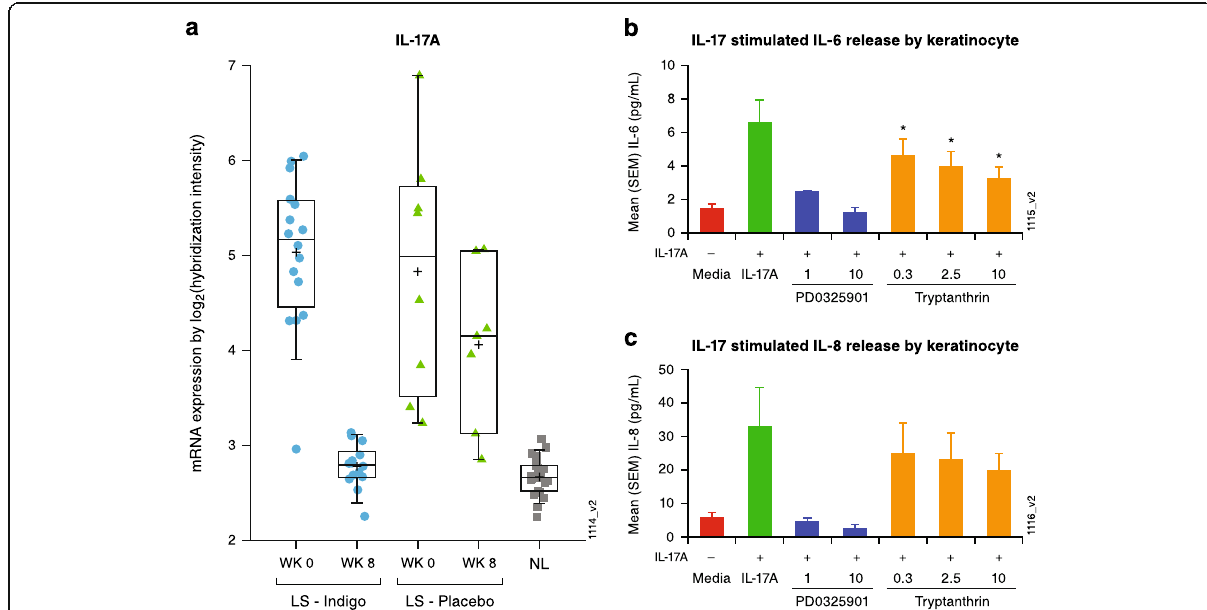
Fig. 5 Indigo naturalis ’ impact on the IL-17 pathway. ( a ) Down-regulation of interleukin (IL)-17A mRNA in the lesional skin (LS). Indigo naturalis - treated samples ( blue filled-circle ) are the left columns (week 0 [WK 0]: n = 16; week 8 [WK 8]: n = 14); placebo-treated samples ( green triangles ) are the middle two columns (WK 0: n = 8; WK 8: n = 7), and baseline nonlesional (NL) samples (gray square) are the right column ( n = 23); ( b ) inhibition of IL-17-induced IL-6 secretion in cultured human keratinocytes. 100 mg/mL of IL-17 is present in all samples except media alone (first column). Compounds are tested in the following order: PD 0325901 1 μ g ( n = 2), 10 μ g ( n = 2); Tryptanthrin 0.3 μ g ( n = 7), 2.5 μ g ( n = 7) and 10 μ g ( n = 7). * T-test p -value ≤ 0.05; ( c ) inhibition of IL-17-induced IL-8 secretion in cultured human keratinocytes. 100 mg/mL of IL-17 is present in all samples except media alone (first column). IL, interleukin; mRNA, messenger RNA; SEM, standard error of